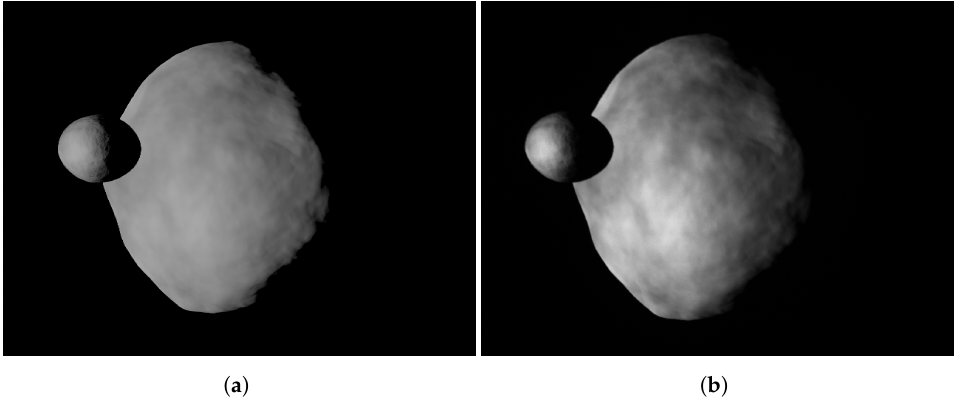
Figure 22. Example image taken during the CRP (see Piccolo et al. [31]). ( a ) Image taken by the camera in the virtual world. ( b ) Image taken by the camera in